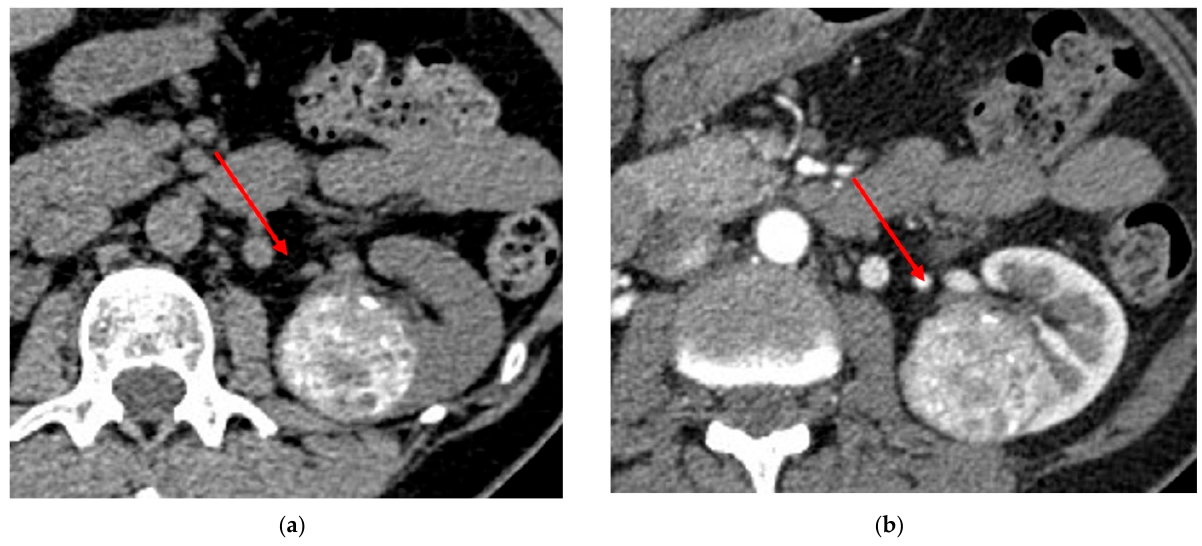
Figure 6. Abdominal CT of an incidentally detected intraparenchymal renal lesion: ( a ) shows multiple macroscopic calcifications in a noncontrast CT; ( b ) shows that the mass is hypovascular in the arterial phase. The lesion is histologically confirmed as chRCC.